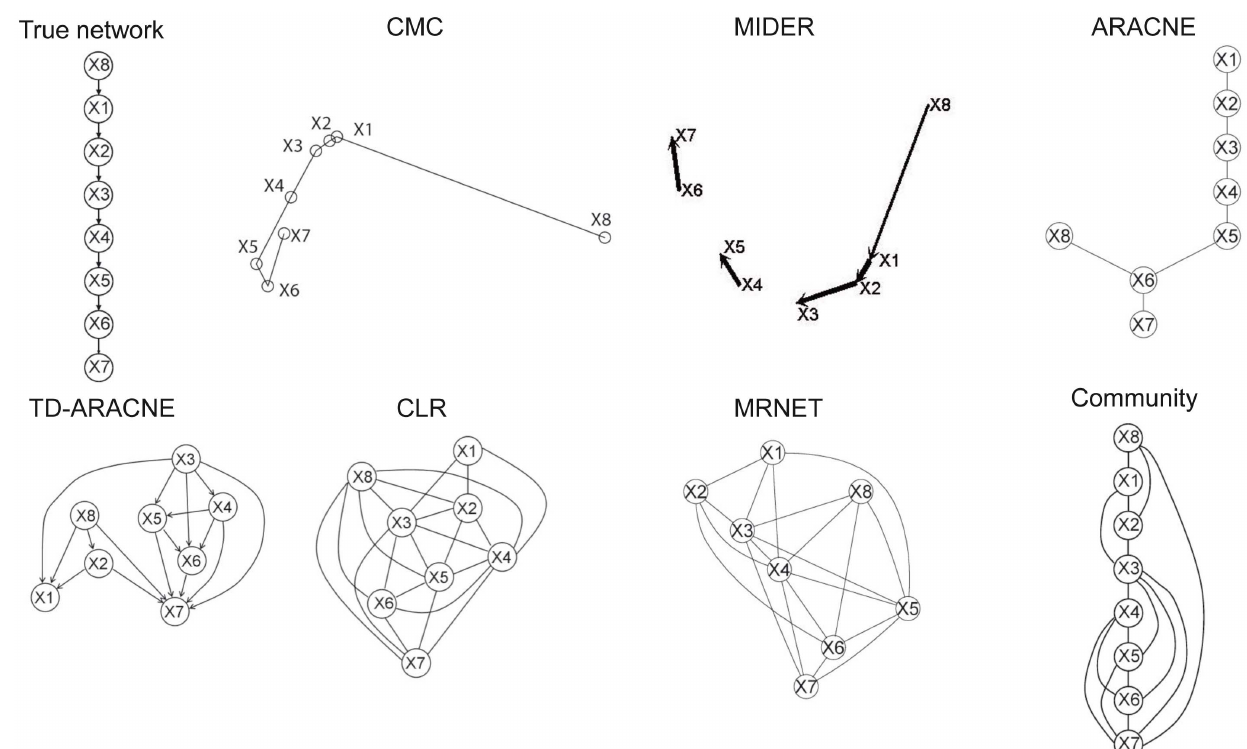
Figure 6. Benchmark B2. Reaction chain with 8 species.